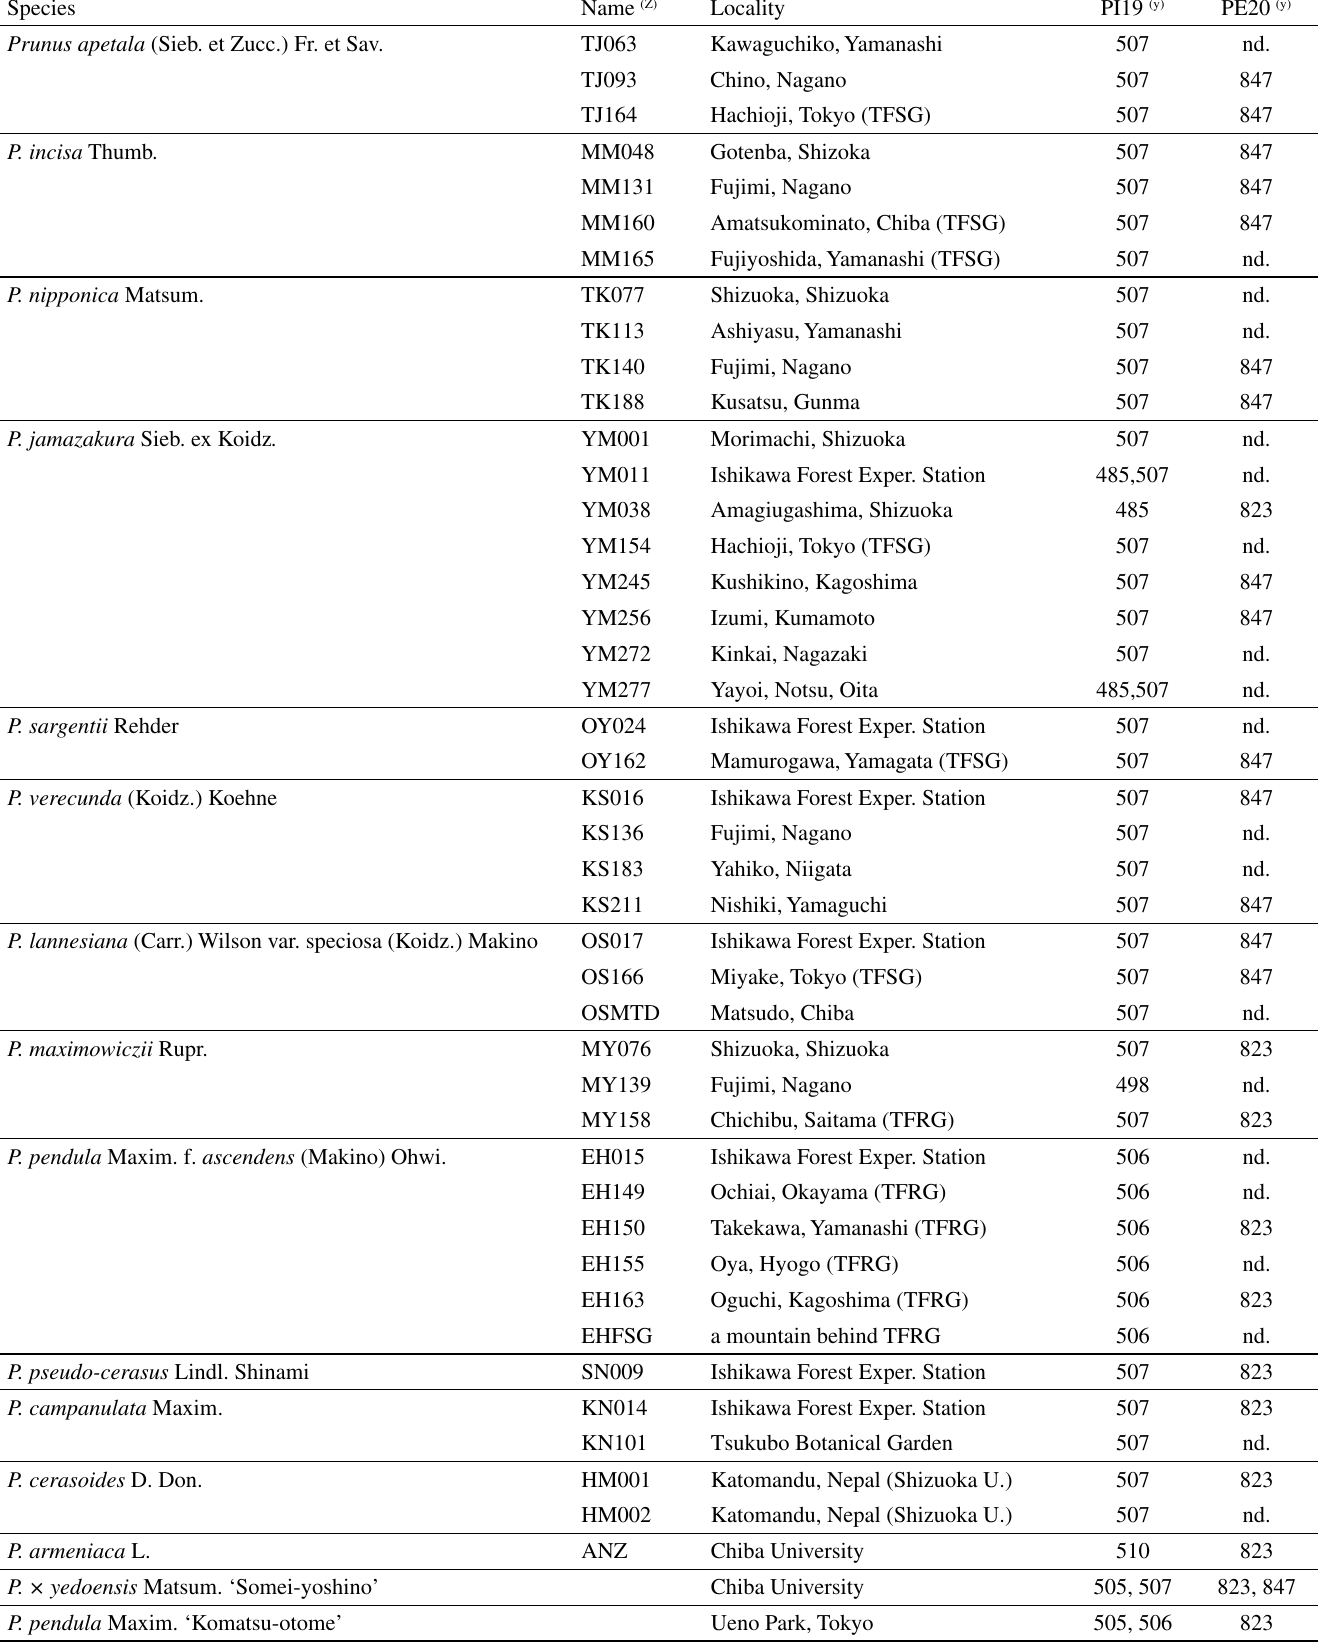
Table 1 - Samples used in this study